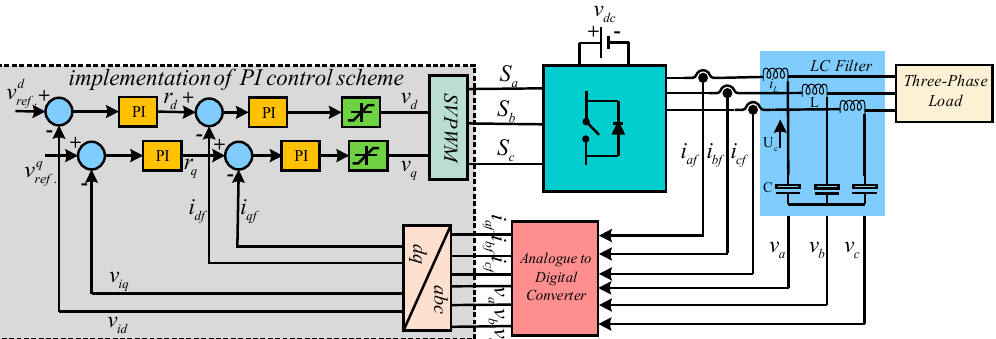
Figure 20. Schematic of a PI control algorithm for a VSI.